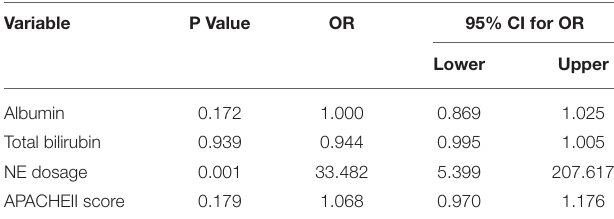
TABLE 3 | Multivariate logistic regression modeling using statistically significant univariate variables associated with 6h Lactate Clearance < 10%. Variable